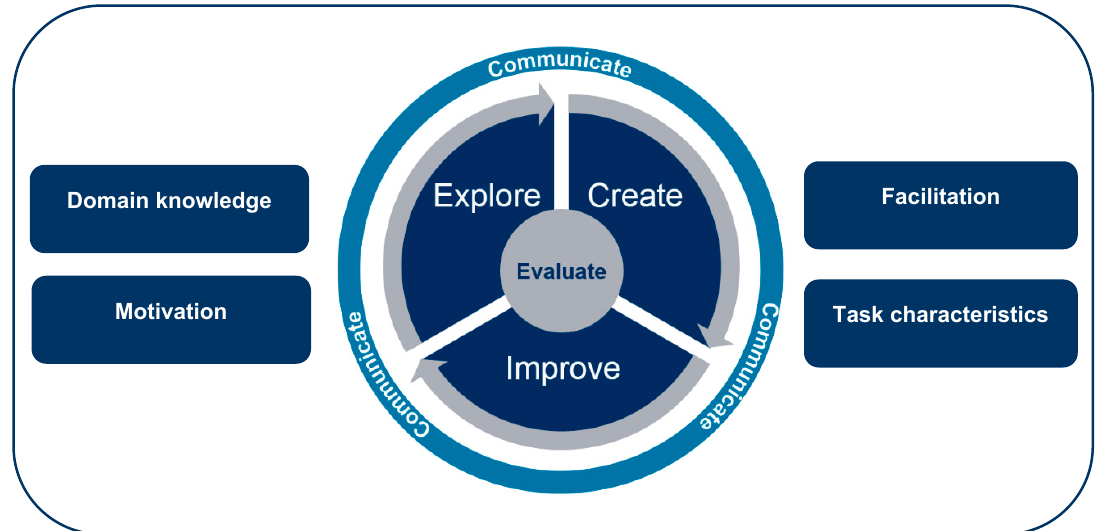
Figure 1. Creative thinking model for learning and assessment.